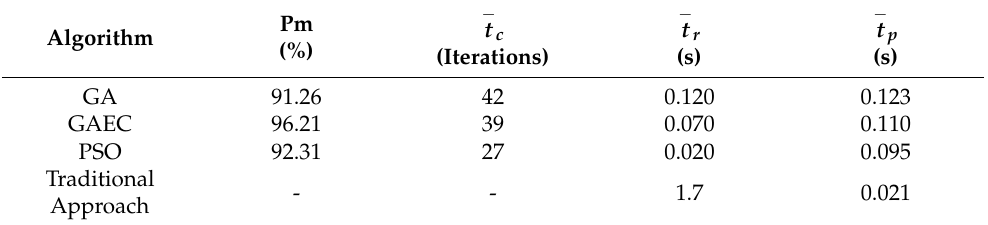
Table 1. Comparison between GA, GAEC, PSO, and Traditional Approach in the Smart Grid Context.